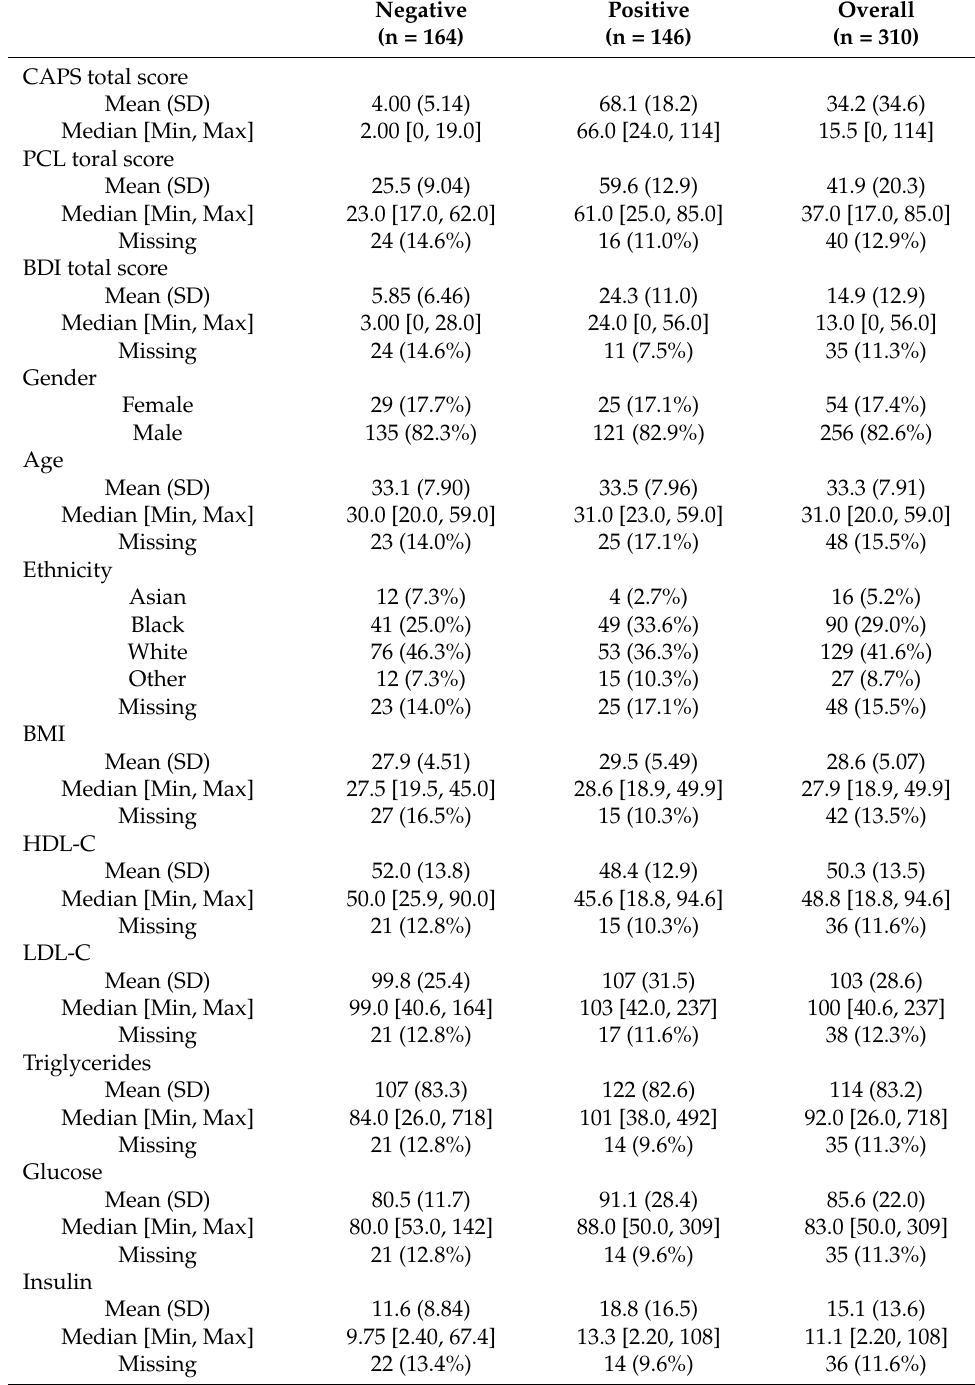
Table 3. Descriptive table for SBC